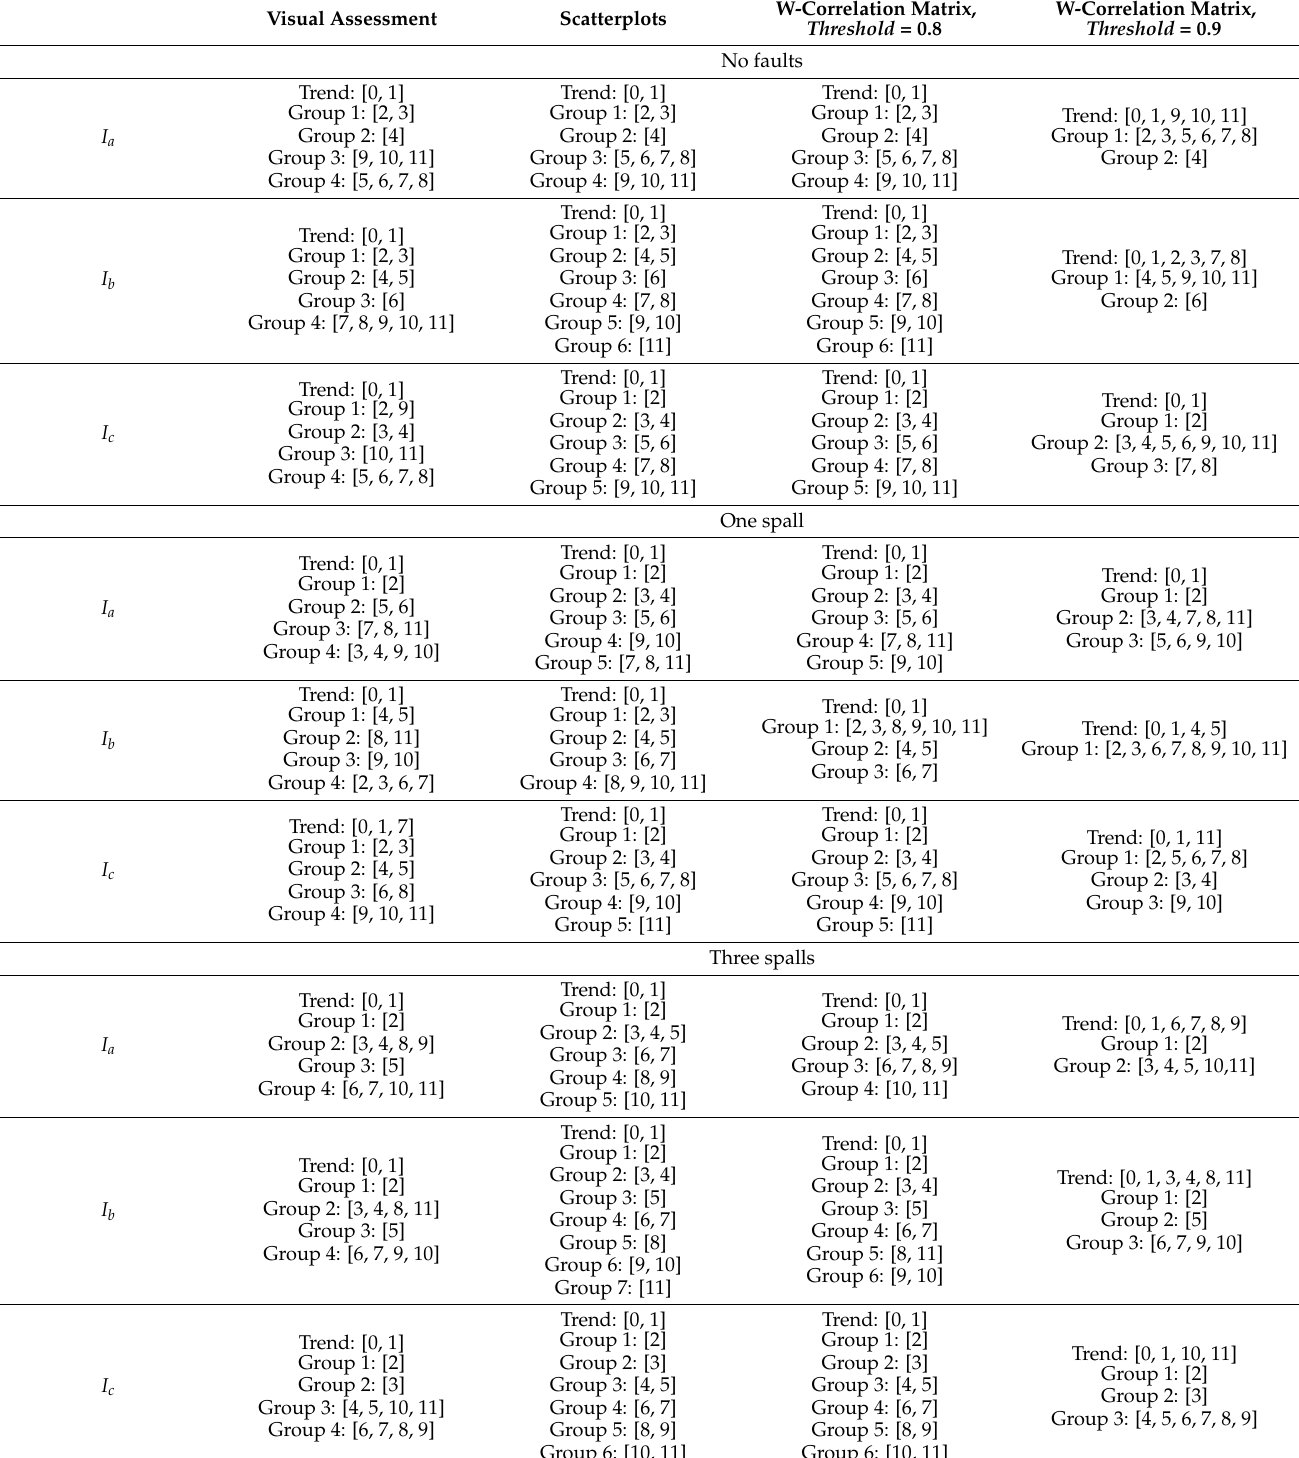
Table 4. Comparison of the results obtained by grouping the components. Visual Assessment Scatterplots W-Correlation Matrix, Threshold = 0.8 W-Correlation Matrix, Threshold = 0.9 No